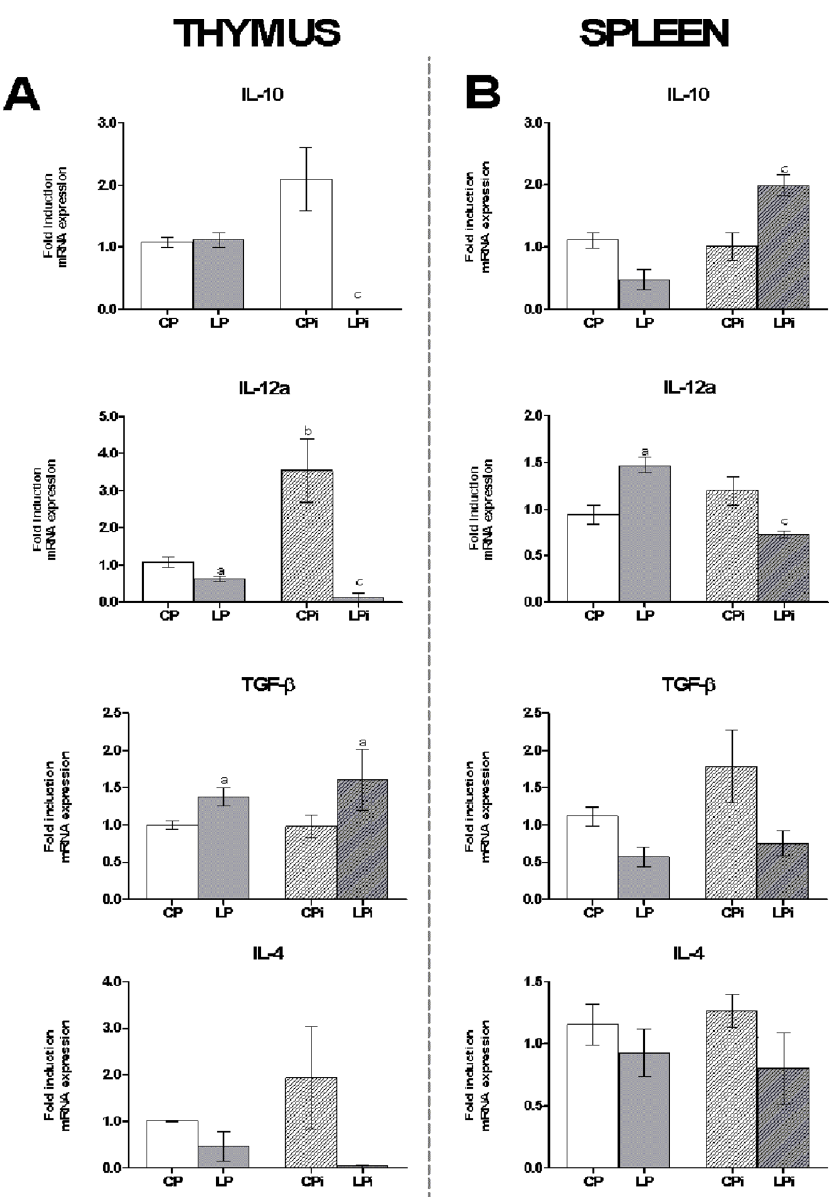
Fig. 7. Protein malnutrition dysregulated cytokine expression in thymocytes and splenocytes of mice infected with L. infantum . IL-10, IL-12a, TGF- b , IL-4 and IFN c mRNA expression levels were measured by qPCR in ( A ) thymocytes and ( B ) splenocytes of each experimental group. The values are expressed as normalized ratios between the target gene expression and the geometric median of the ATP-5, GAPDH and CYC-1 genes. The values are expressed in pg/mL ¡ SEM. CP: animals fed 14% protein diet; LP: animals fed 4% protein diet, CPi: animals fed 14% protein diet and infected; LPi: animals fed 4% protein diet and infected. Two-way ANOVA analysis with Bonferroni pos-hoc test. Statistical differences due to diet: a (p , 0.001), infection: b (p , 0.05) and interaction between diet and infection: c (p , 0.05).